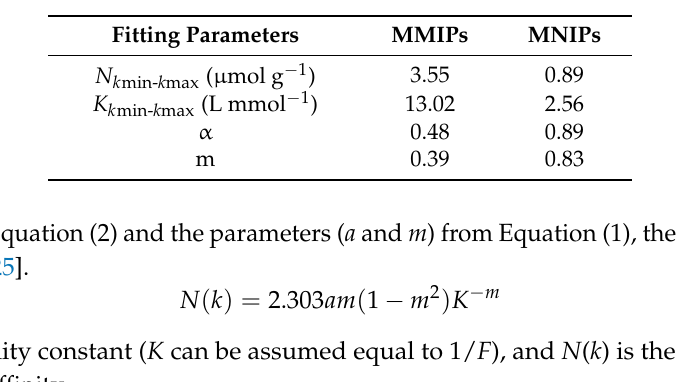
Table 1 summarized the calculated fitting parameters. For MMIPs and MNIPs, the